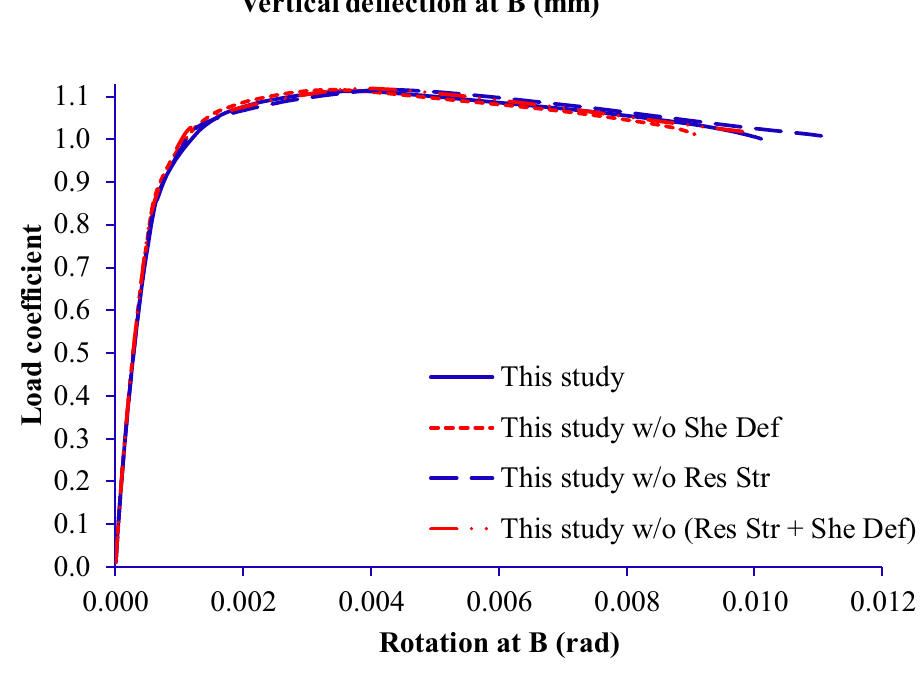
Fig. 21 Load-rotation relation- ship at B of six-story